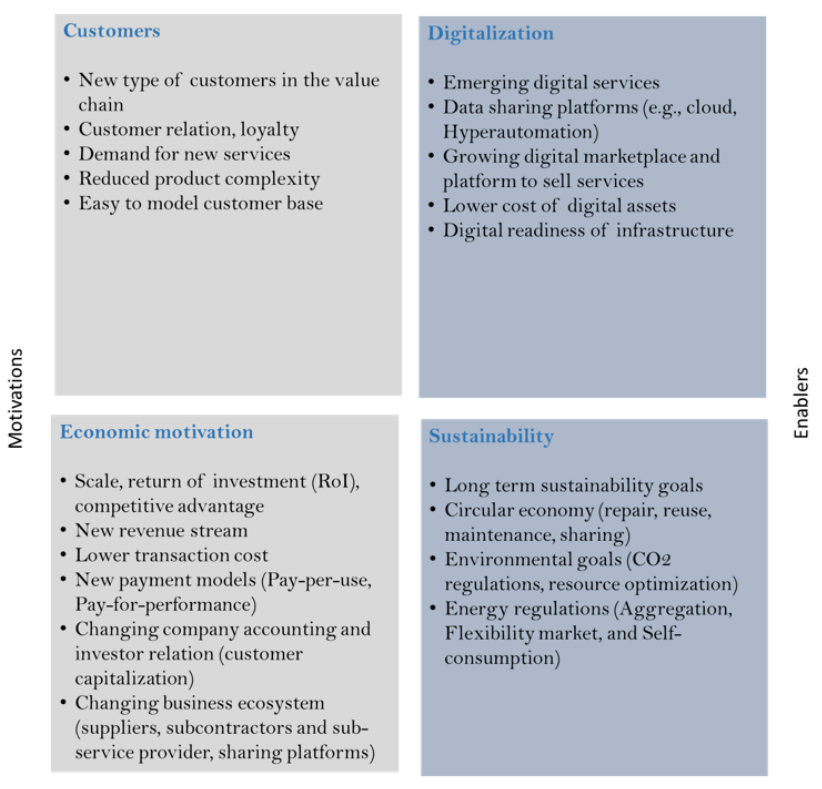
Figure 2. Service business model motivations and enablers in energy